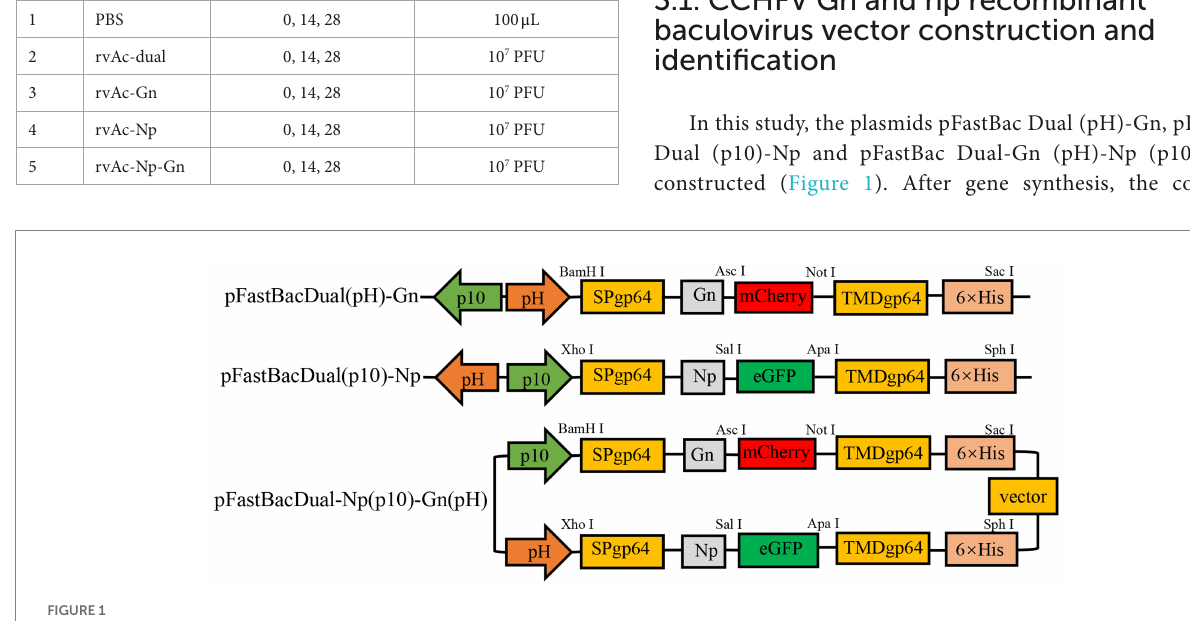
FIGURE 1 Recombinant plasmid